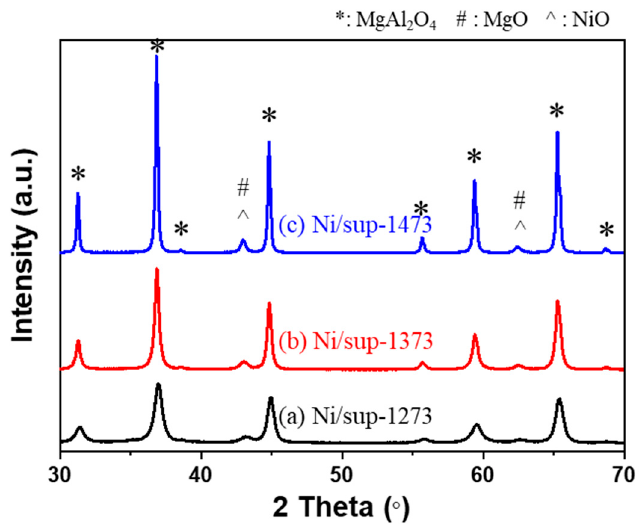
Figure 5. XRD patterns of the egg-shell-type 3.5 wt% Ni/MgAl 2 O 4 pellet catalysts.